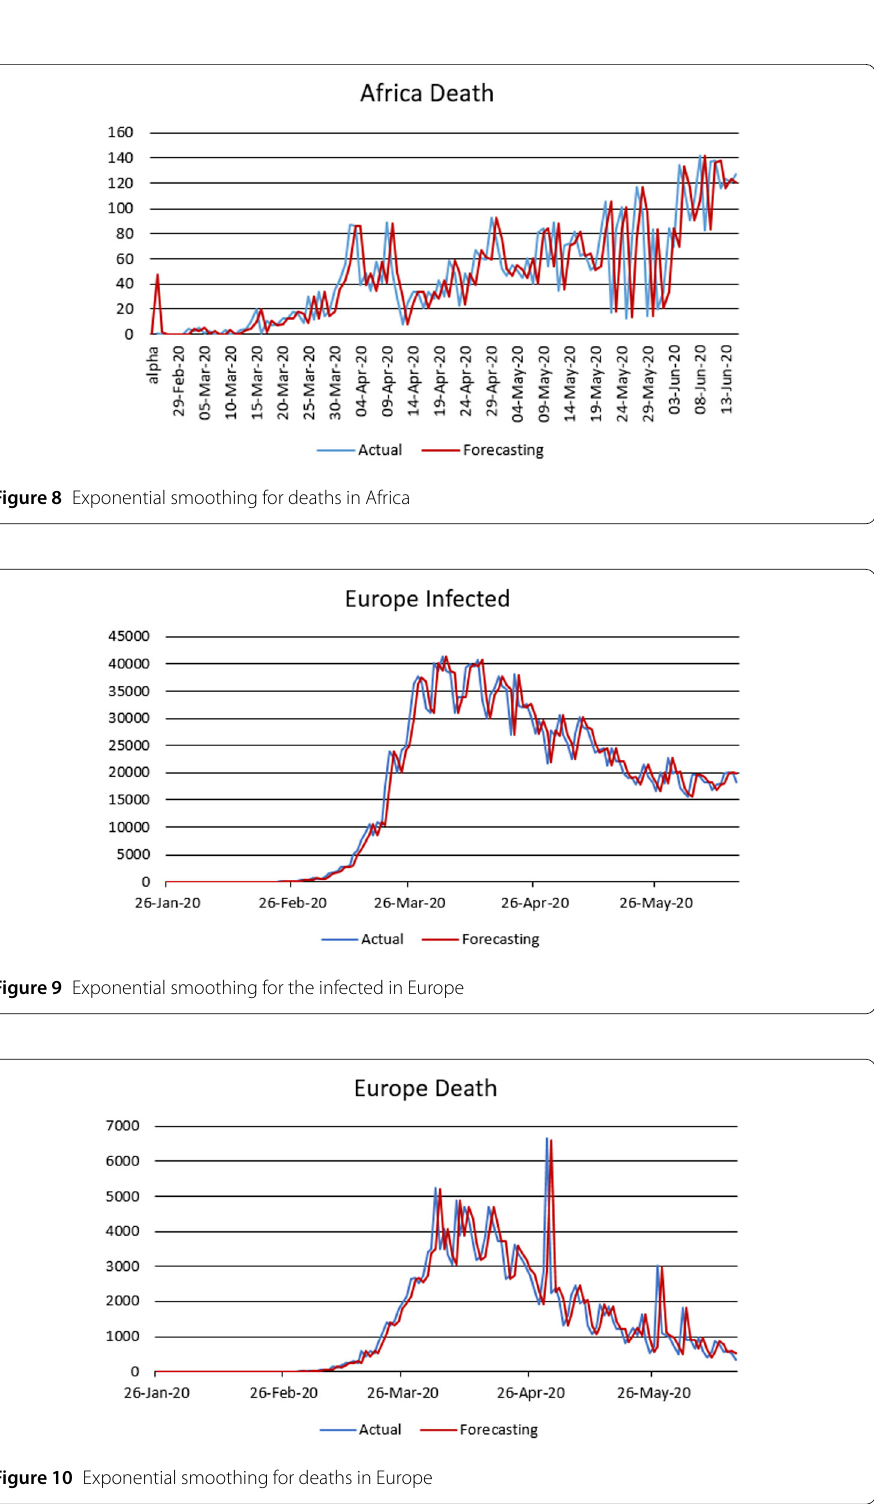
scenarios or events that could be observed in the near future, the daily numbers of deaths and infections. Numerical simulation are presented in Figs. 11, 12, 13 and 14. In Figs. 15, 16, 17, and 18, we present fitting with smoothing spline for the infected and deaths in Africa and